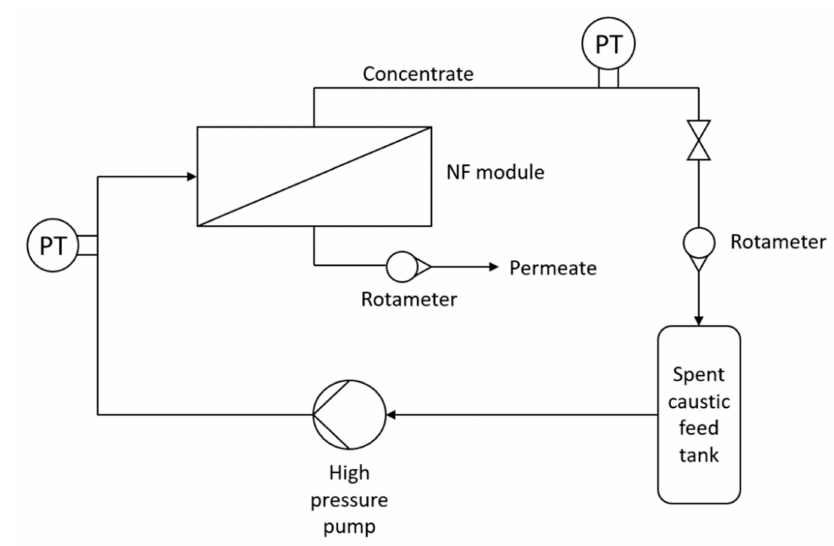
Figure 1. Schematic representation of the NF experimental setup.